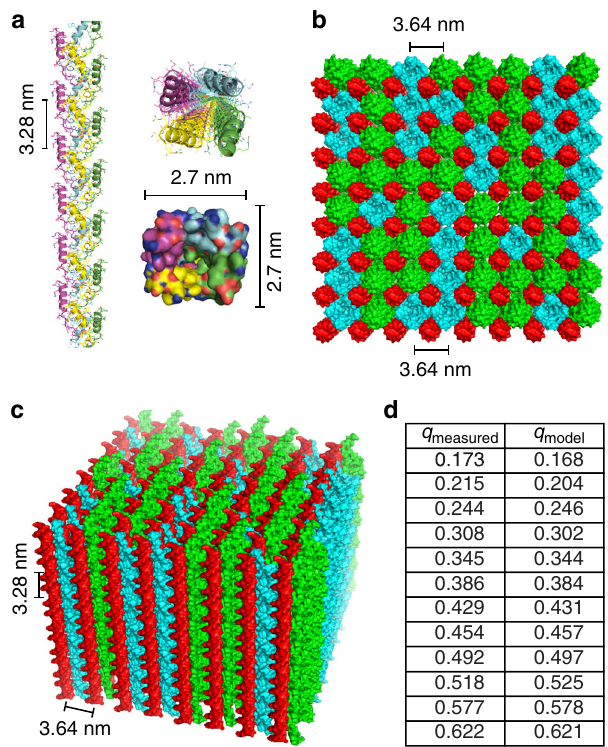
Fig. 2 Structure of melittin-double-stranded DNA (dsDNA) complexes from molecular simulations. a Side and top views of the melittin proto fi bril self-assembled in the presence of dsDNA. The cross-sectional dimensions of the proto fi bril is 2.7 nm × 2.7 nm. The helical pitch of the proto fi bril is 3.28 nm per turn. Top ( b ) and side ( c ) views of an 8 × 8 melittin-dsDNA square lattice from molecular dynamics simulations. Columnar dsDNA is colored red, and the melittin proto fi bril is colored green (N to C terminus polarity) and teal (C to N terminus polarity). Random polarity of the melittin proto fi bril is assumed. The inter-dsDNA spacing from the molecular model obtained from simulation is d = 3.64 nm, which agrees well with the predicted inter-dsDNA spacing from small-angle X-ray scattering (SAXS). The out-of-plane lattice parameter of c = 3.28 nm also agrees with the simulated pitch of the melittin proto fi bril. d There is good agreement between the observed structure factor peaks from SAXS with peaks recovered from theoretical X-ray scattering of the lattice model in b